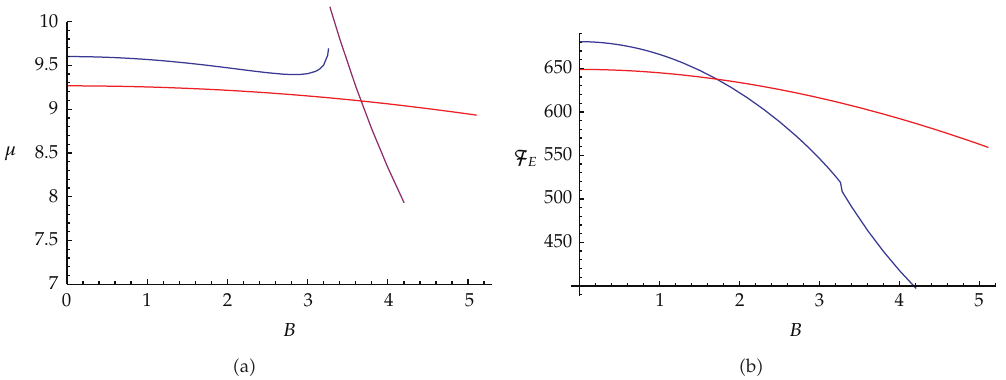
Figure 18: For the dense multiquark with d (cid:8) 100 , T (cid:8) 0 . 10, (cid:3) a (cid:4) the chemical potential, (cid:3) b (cid:4) the free energy as a function of B . The multiquark curves in red are compared with the χ S-QGP curves in blue for the chemical potential and the free energy.